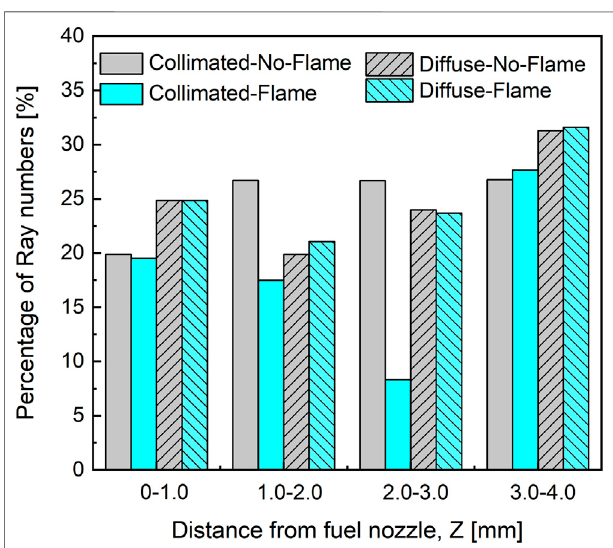
FIGURE6 | Percentage of ray numbers for the twooptical layouts under fl ame on and off